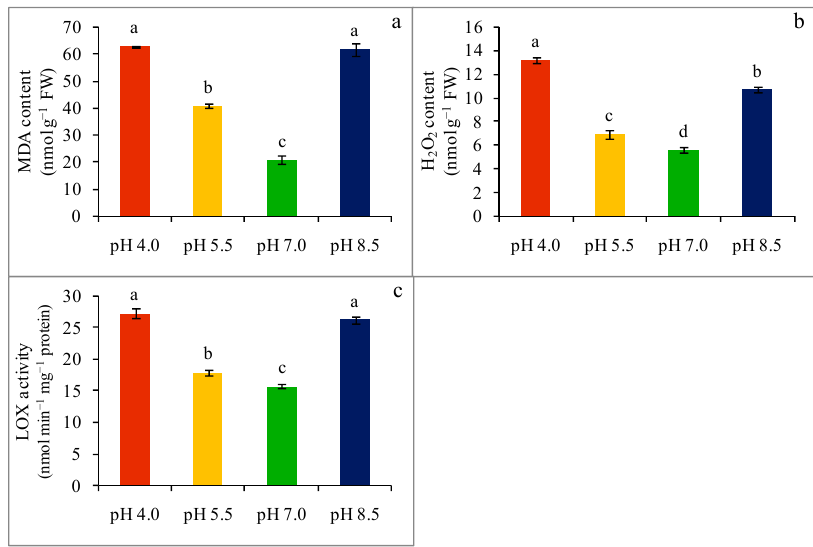
Figure 2. Malondialdehyde (MDA) content ( a ), H 2 O 2 content ( b ), and LOX activity ( c ), of wheat leaves under different levels of pH. Mean ( ± SD) was computed from three replications of each treatment. Bars with dissimilar letters are significantly different at p ≤ 0.05 from Fisher’s LSD test.